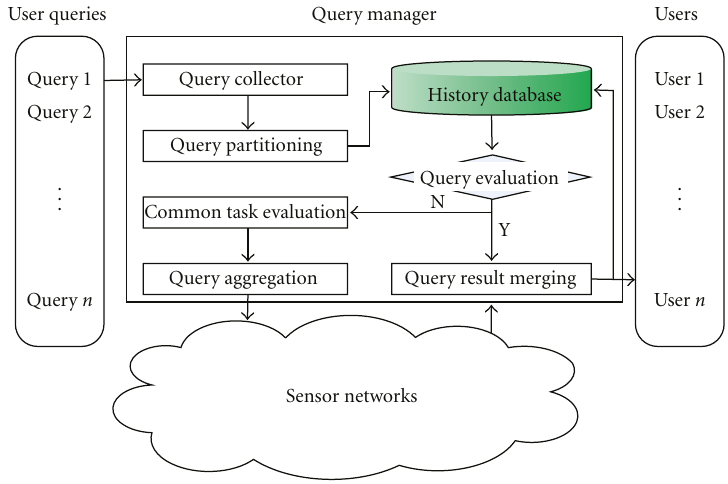
Figure 1: Query management